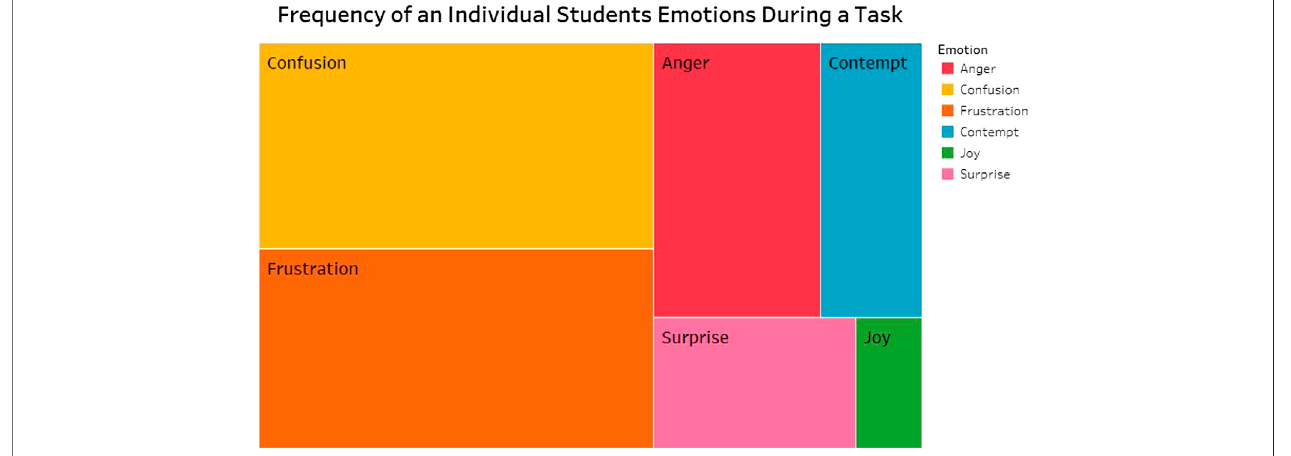
FIGURE 1 | Data visualization depicting real-time data of six different emotions (i.e., joy, frustration, anger, contempt, surprise, and confusion) for a single student engaged in a learning